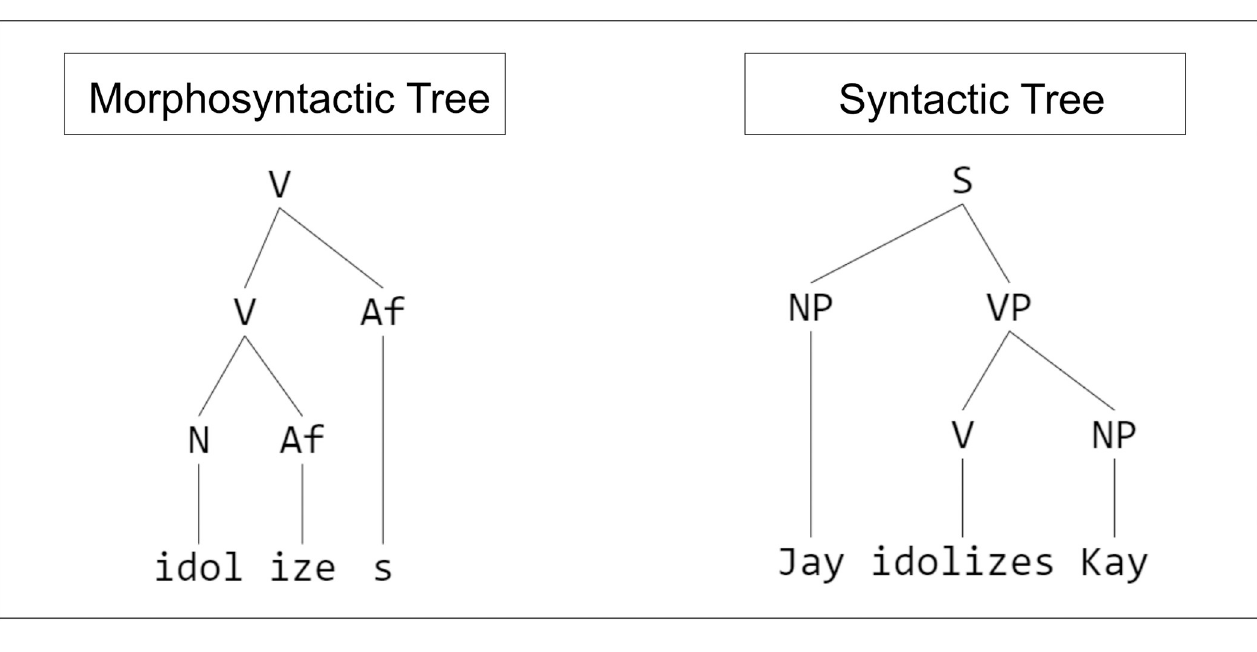
Fig 1. Syntactic and morphosyntactic similarity. The similarity of syntactic and morphosyntactic tree diagrams suggests that the two result from similar structure building operations. “Af” stands for Affix, “N” for Noun, “NP” for Noun Phrase, “V” for Verb, and “VP” for Verb Phrase.